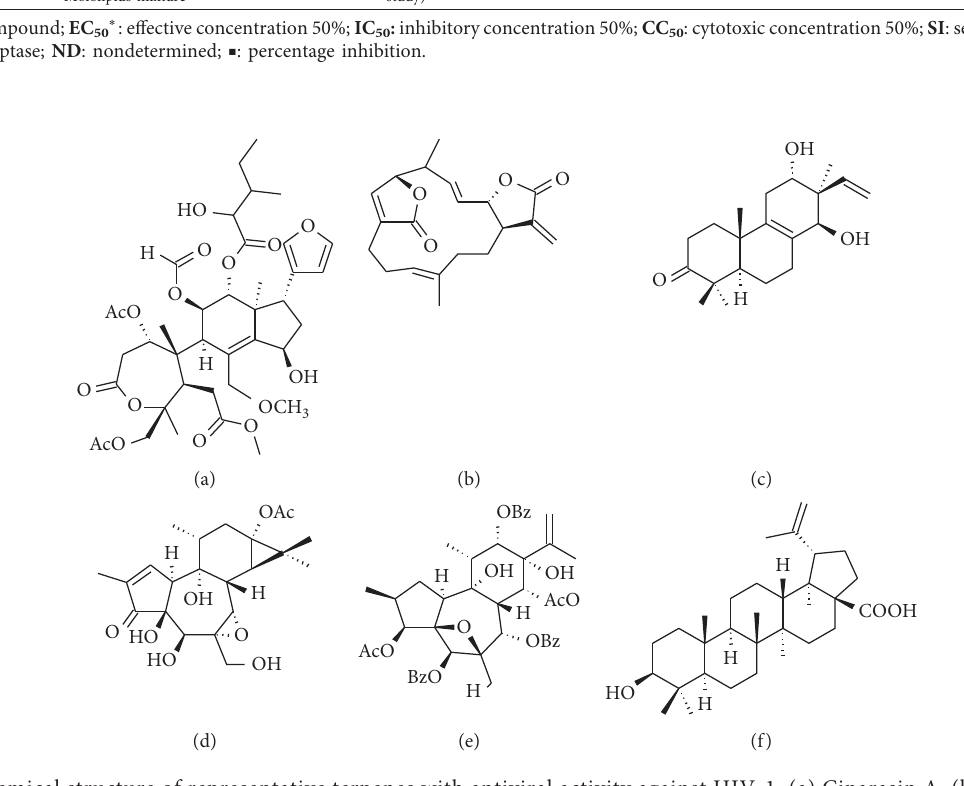
Figure 2: Chemical structure of representative terpenes with antiviral activity against HIV-1. (a) Ciparasin A. (b) Ovatodiolide. (c) Excocarinol A. (d) Excoecafolin A. (e) Trigothysoid J. (f) Betulinic